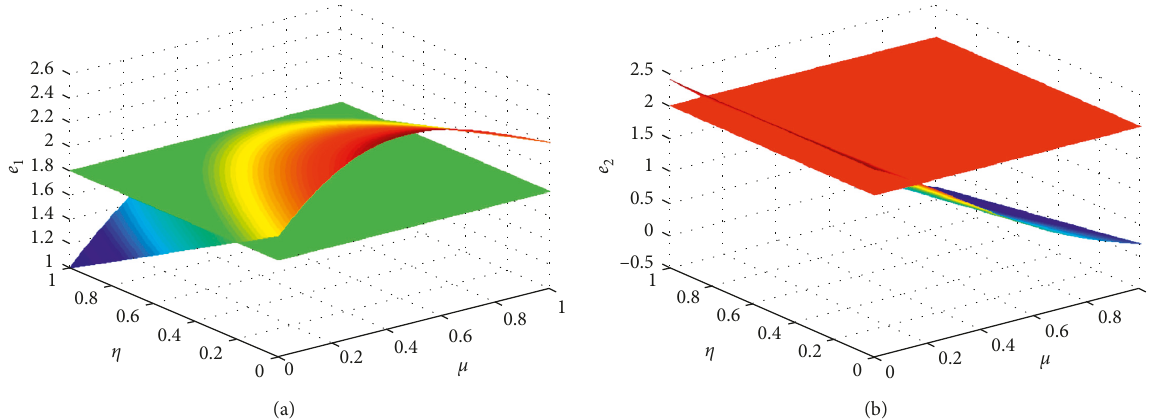
Figure 3: Effects of coefficients of converting conflicts to benefit and the loss caused by conflicts on effort levels. (a) Effects of (b) Effects